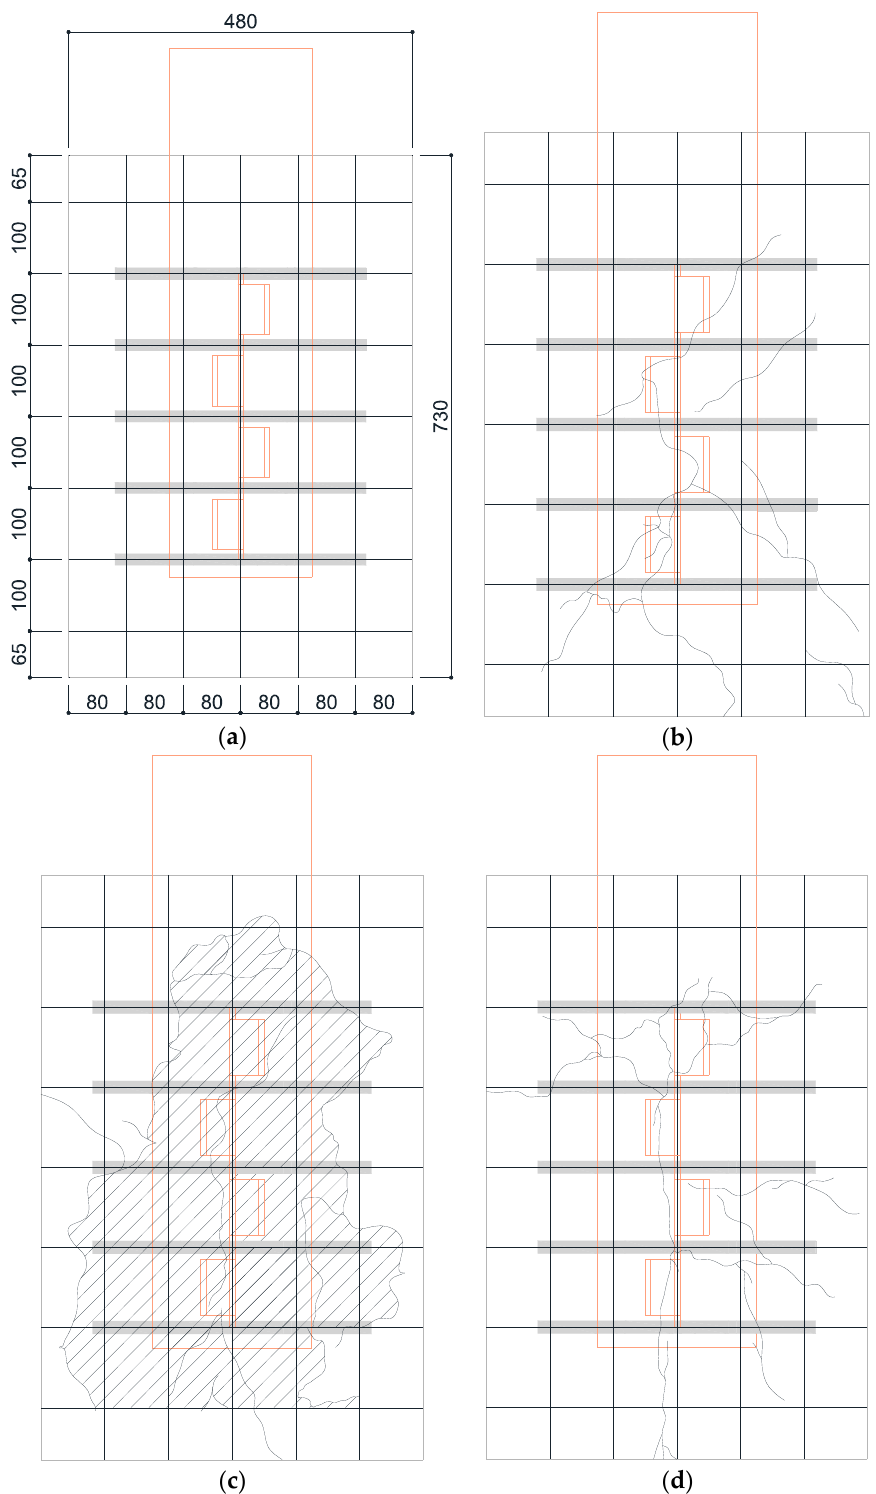
Figure 7. Concrete crack patterns of SY-D16: ( a ) Grid lines (Unit: mm); ( b ) M1; ( c ) M2 (Slashed area: Pry-out failure); ( d ) M3.